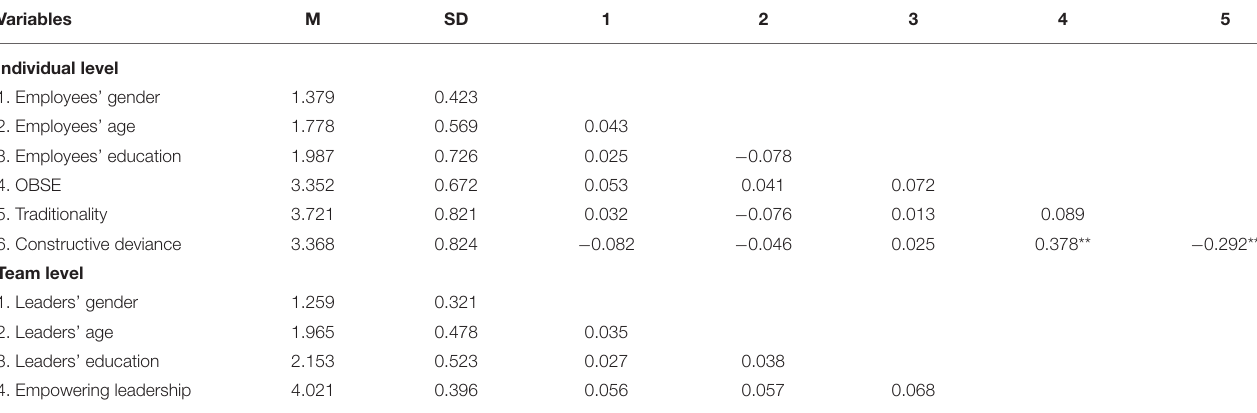
TABLE 2 | Means, standard deviations and correlations.